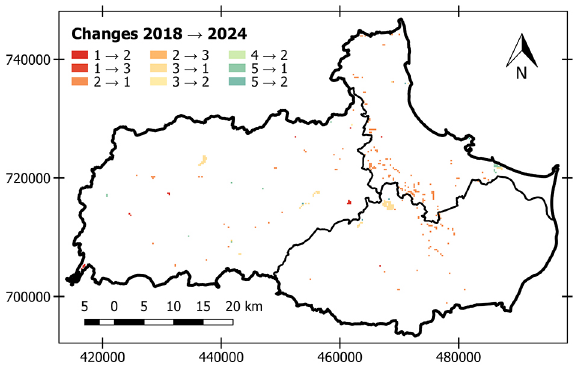
Fig. 8. Spatial distribution of land cover